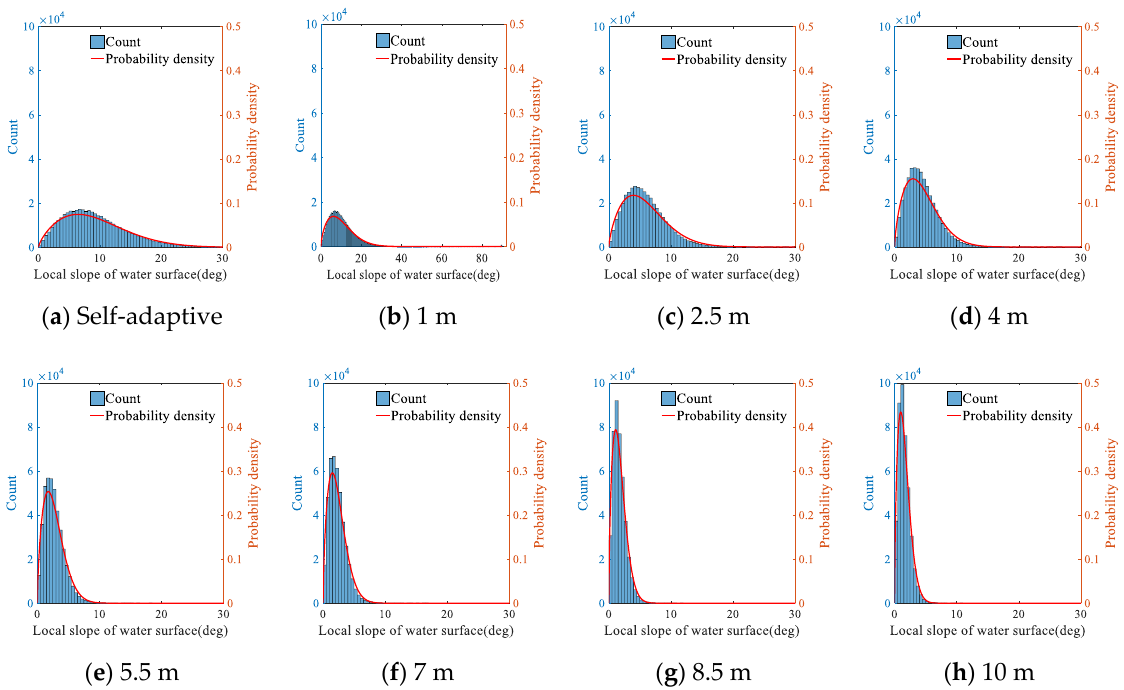
Figure 12. Statistical distribution of the incidence angle correction value using different neighborhood radii in Experimental Area A.